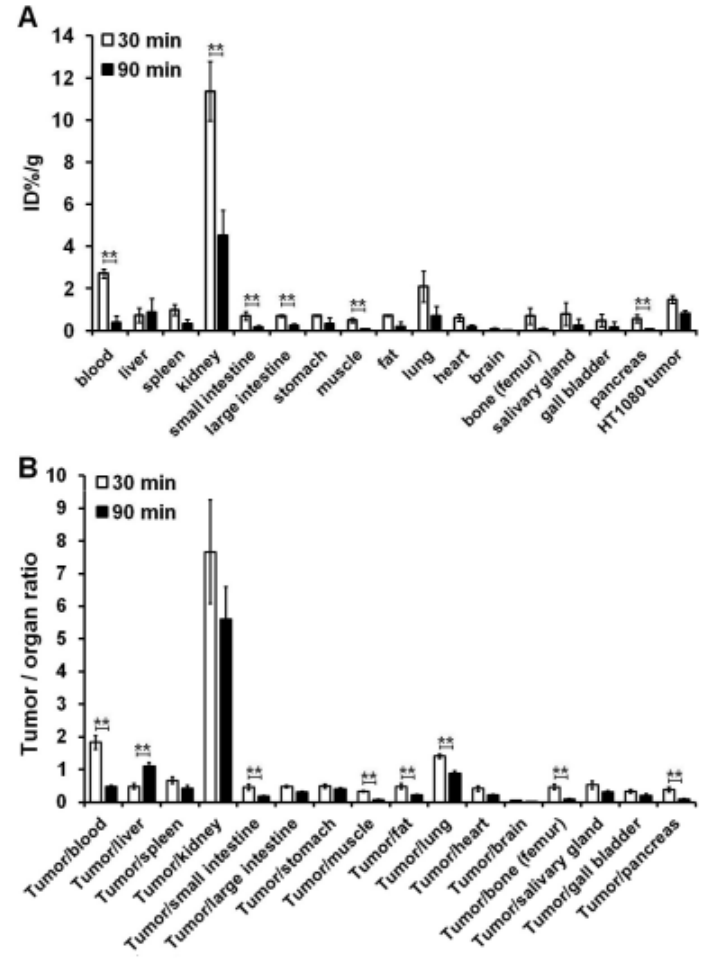
Figure 4. Ex vivo biodistribution ( A ) of [ 213 Bi]Bi-DOTAGA-cKNGRE and tumour-to-organ ratios ( B ) in HT1080 tumour-bearing study mice 30 and 90 min postinjection of approximately 5 MBq of the APN/CD13 selective radiotracer. The uptake values were obtained as mean %ID/g ± SD. n = 8 mice/time point. Significance level between 30 and 90 min for the corresponding radio- pharmaceutical: p ≤ 0.01 (**). 213 Bi: bismuth-213; DOTAGA: 1,4,7,10-tetrakis(carboxymethyl)- 1,4,7,10-tetraazacyclododecane glutaric acid; cKNGRE: cyclic Lysine–Asparagine–Glycine–Arginine– Glutamic acid; APN: aminopeptidase N; SD: standard